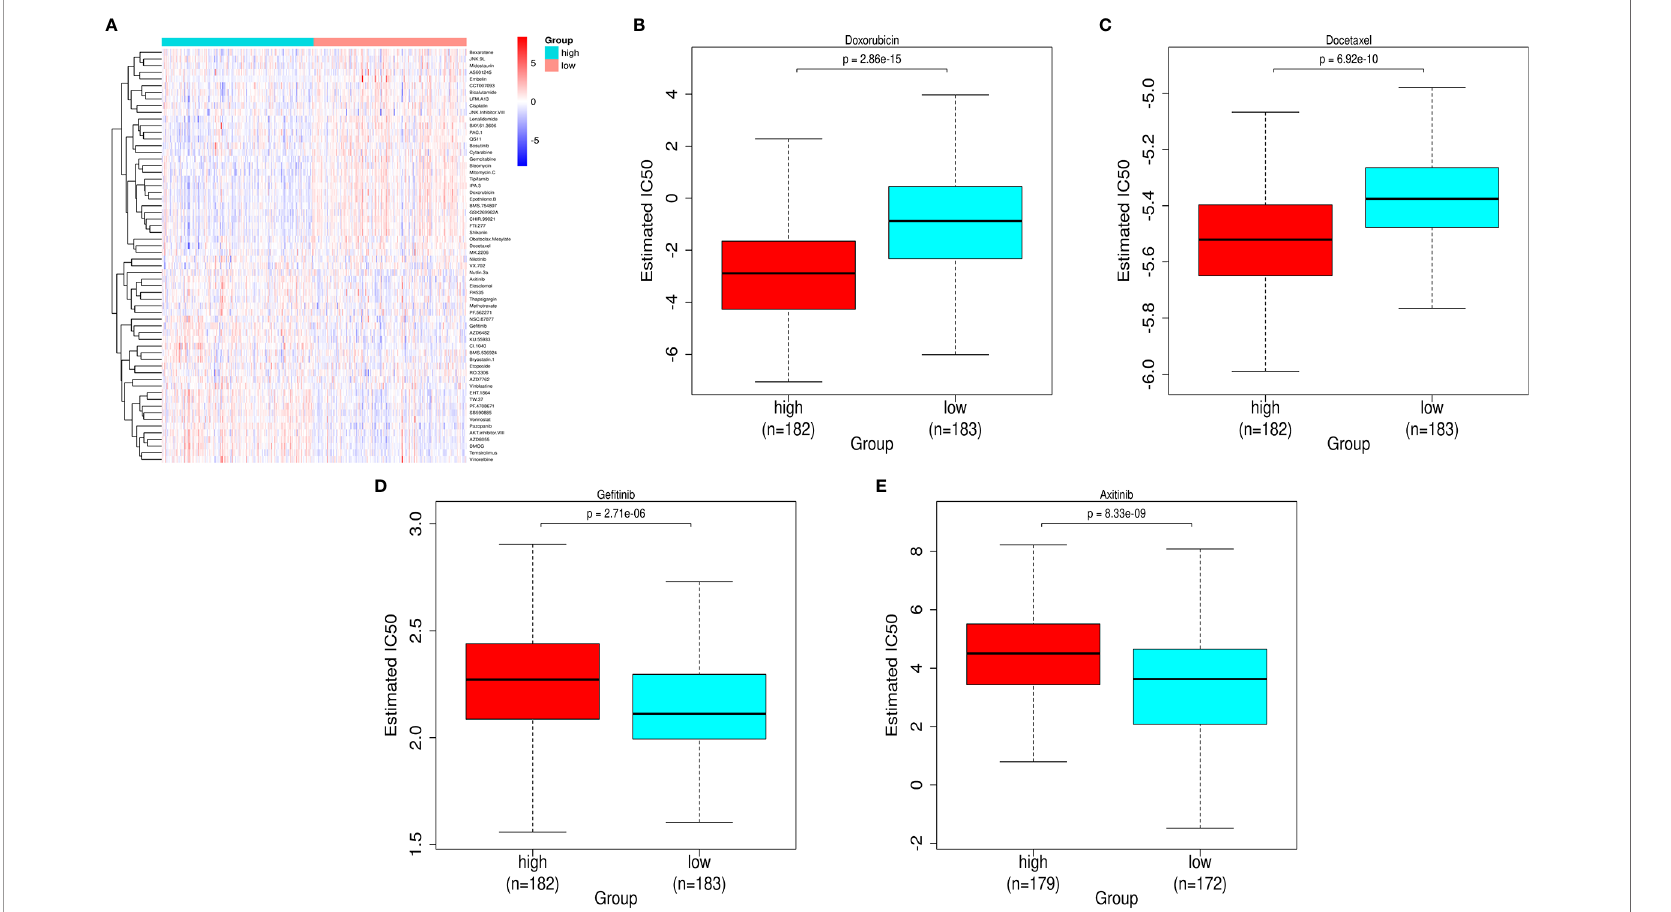
FIGURE 7 | Prediction of the differences in HCC chemotherapy drug sensitivity in the high- and low-risk groups. (A) Heat map and clustering analysis of IC50 prediction of HCC chemotherapeutic agents in the high- and low-risk groups. (B) Differences in doxorubicin sensitivity in the high- and low-risk groups. (C) Differences in docetaxel sensitivity in the high- and low-risk groups. (D) Differences in Ge fi tinib sensitivity in the high- and low-risk groups. (E) Differences in Axitinib sensitivity in the high- and low-risk